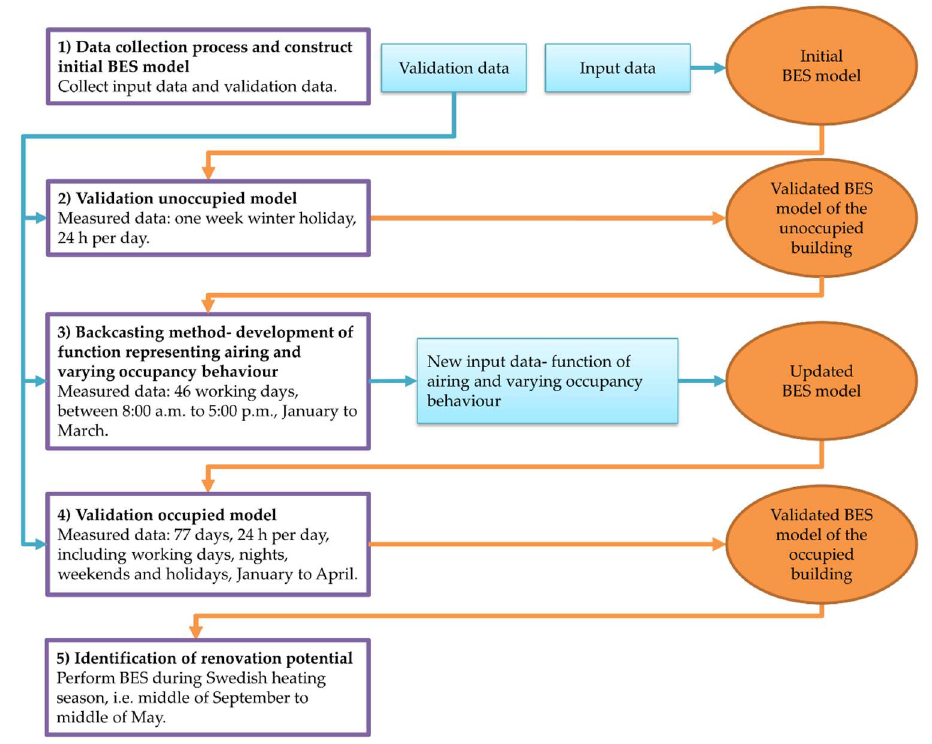
Figure 2. Overview of the research process.